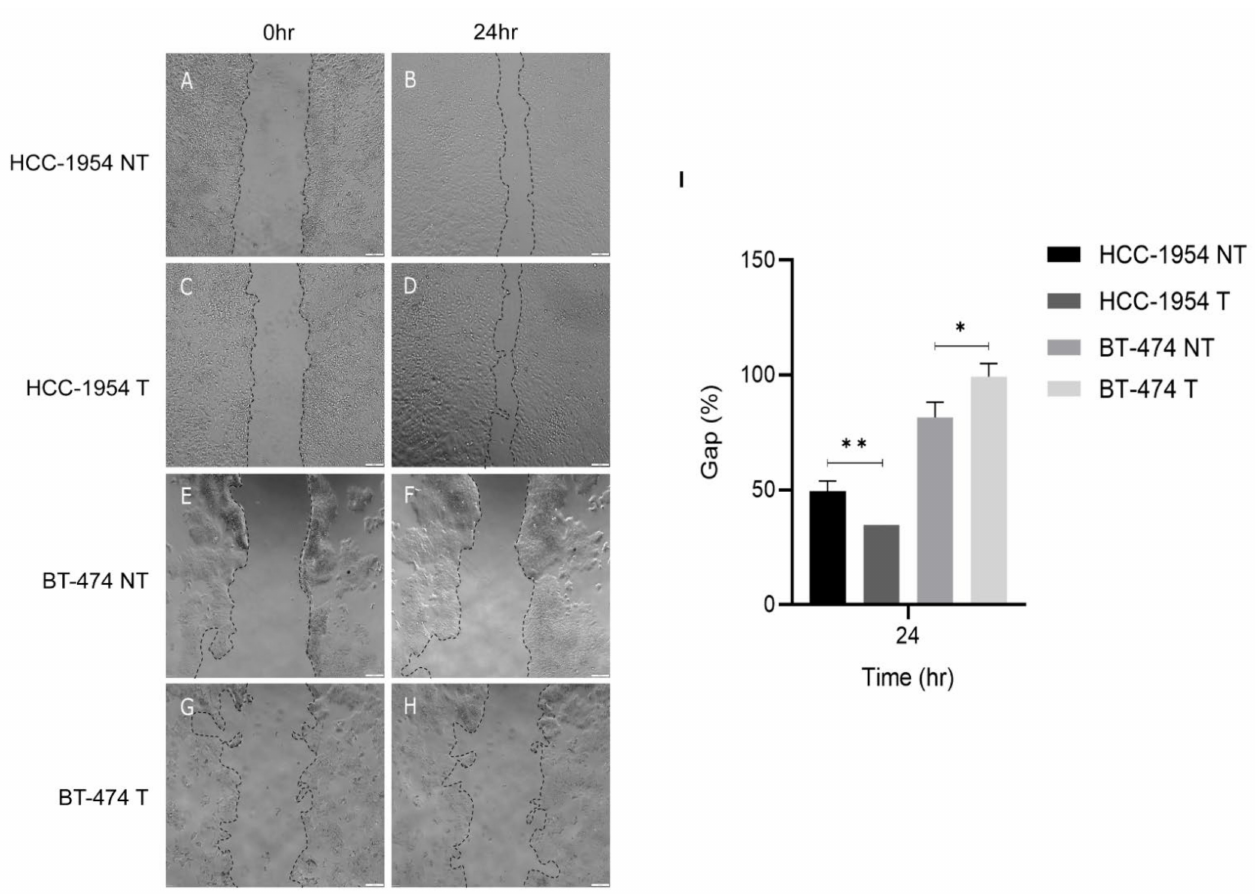
Figure 6. Trastuzumab effect on HCC-1954 and BT-474 migration potential. ( A – D ) Images of HCC-1954 cells and ( E – H ) BT-474 cells. ( A , C , E , G ) when the scratch/wound was performed, and ( B , D , F , H ) 24 h after. ( I ) Quantification of the gap (%). (NT) not-treated and (T) treated. These results show an enhanced migration of HCC-1954 cells with treatment, as evidenced by a smaller gap after after 24 h compared to not-treated cells. Scale bars correspond to 100 µ m. p -value < 0.05 (*); <0.01